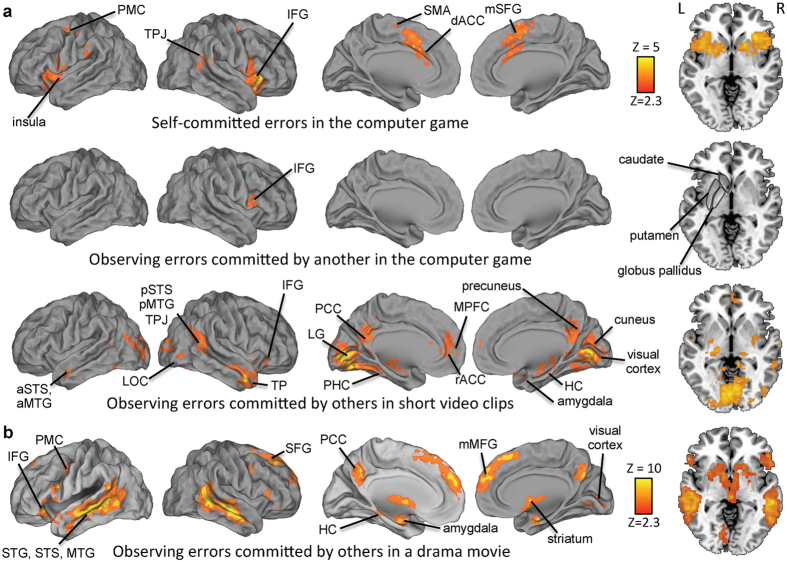
Brain regions showing statistically significant activity related to processing of self-committed and observed errors in Experiment 1 (topmost three panels) and observed errors in Experiment 2 (bottom panel) are indicated with the color maps overlaid on reconstructed cerebral hemispheres and on axial slice at z = −2 mm that cuts through the striatal structures.Shown are, starting from the top panel, brain regions that exhibited statistically significant responses following self-committed errors in the computer game, brain regions that exhibited statistically significant responses following observation of errors committed by another person in the computer game, brain regions with significant hemodynamic activity associated with observation of errors by others in the short video clips, and in the re-edited drama movie. All statistical parameteric maps were thresholded Z > 2.3 and cluster-wise corrected at P < 0.05.